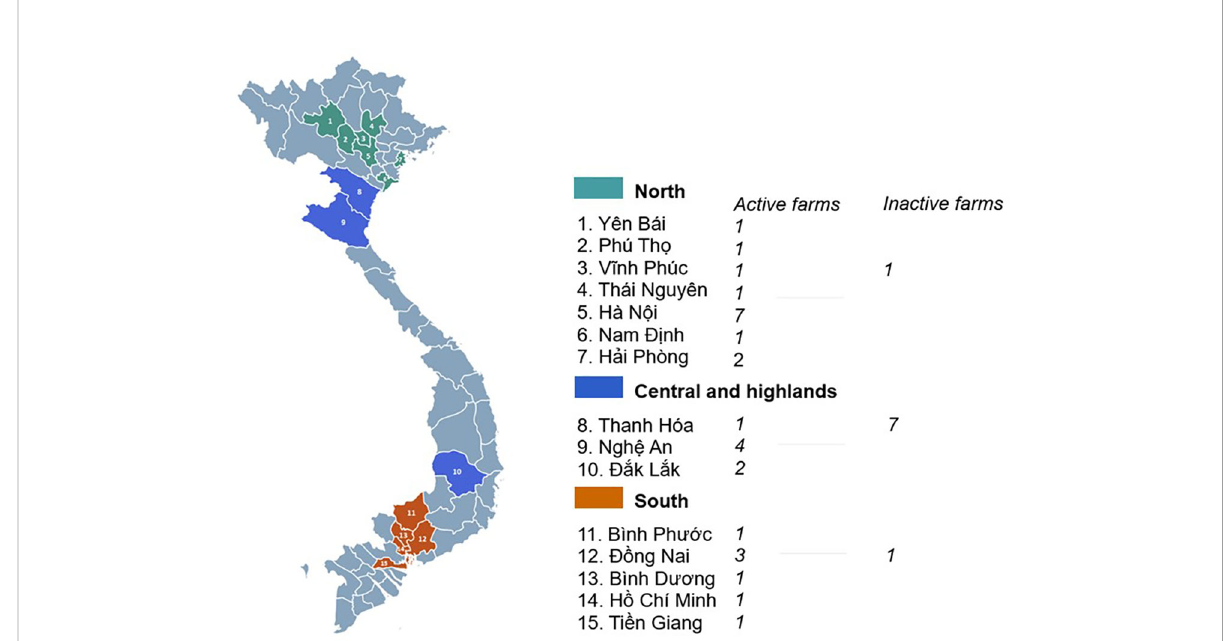
FIGURE 1 The distribution of farm locations across Vietnam, where bear famers were interviewed for this